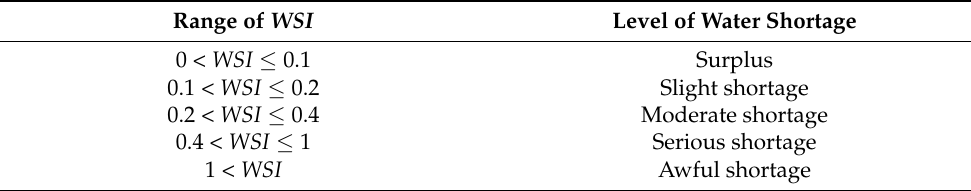
Table 3. Classification standard of WSI.